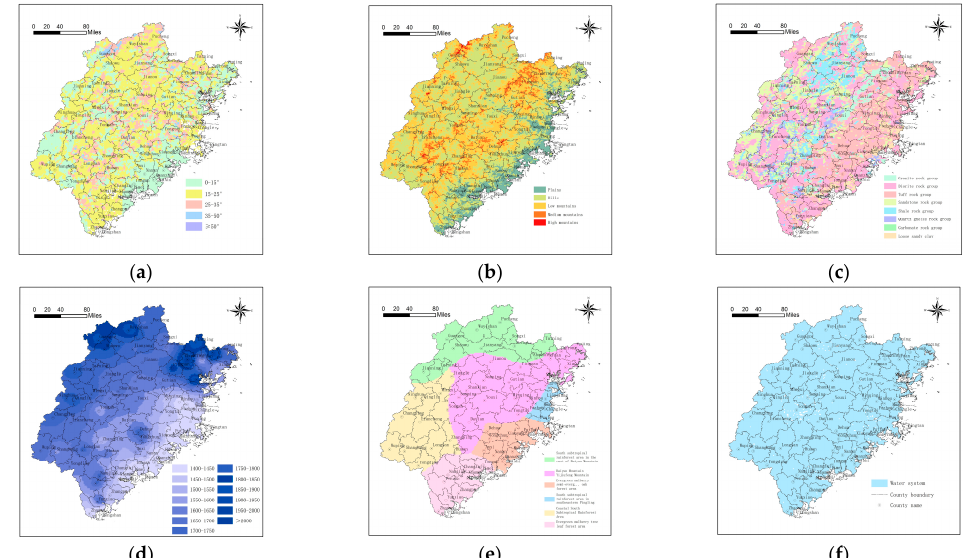
Figure 2. Geological environment factor index of the study area: ( a ) grade, ( b ) geomorphic type, ( c ) formation lithology, ( d ) annual rainfall, ( e ) vegetation type, ( f ) water system. Table 1. Input features and parameters of the training sample set.